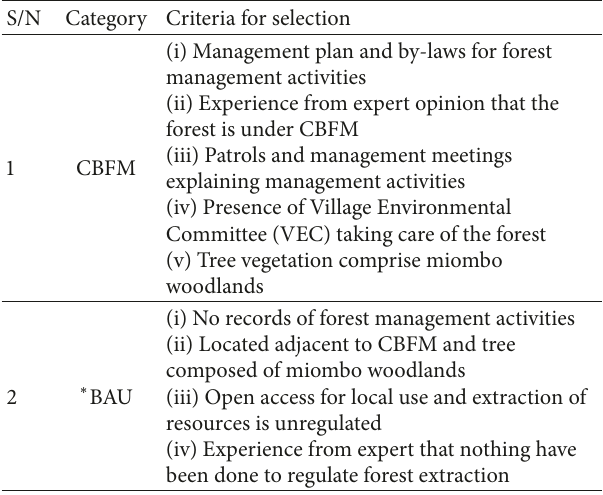
Table 1: Land use categories and criteria used in selection of study